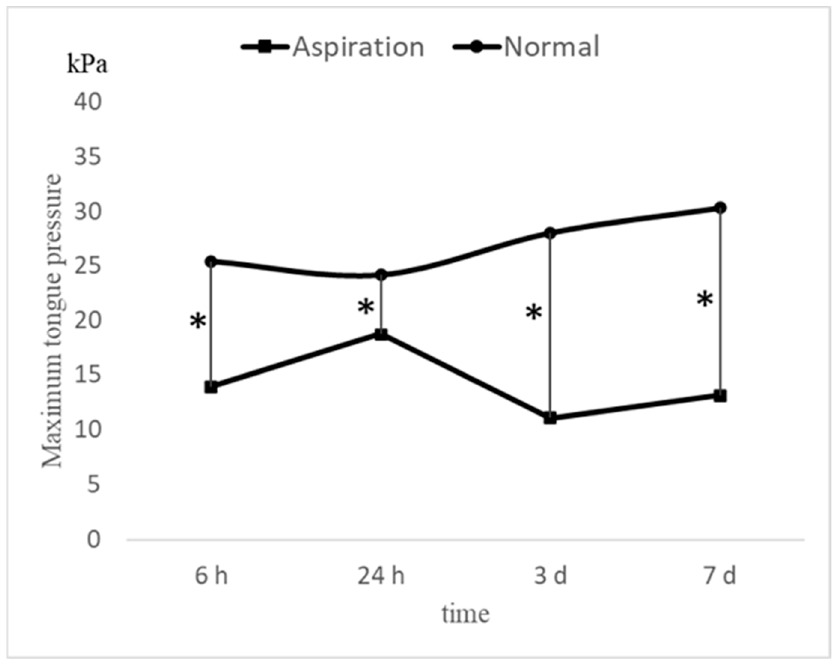
Figure 3. MTP values in the normal and aspiration groups. * p < 0.05; h: hours; d: days. Mann– Whitney U-test.